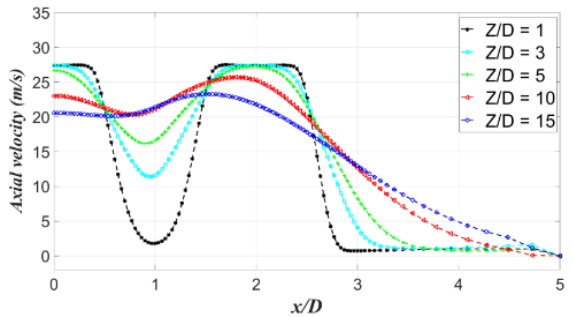
Figure 7. Axial velocity variation in radial direction at di ff erent streamwise locations.